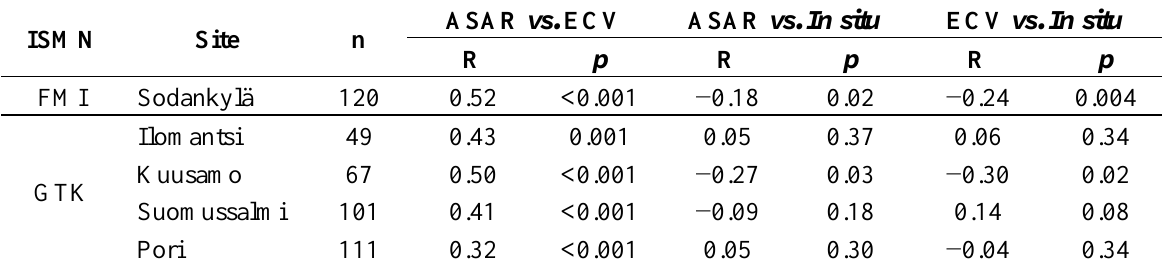
Table 7. Correlation values evaluated between each pair of soil moisture dataset. ASAR vs. ECV ASAR vs. In ISMN Site n